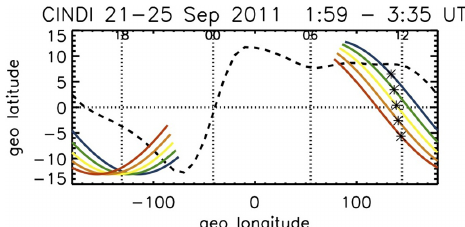
Figure 1. A diagram in geographic longitude and latitude of the ground track swaths from approximately the same universal time on the five quiet days preceding the storm event day (blue is 21 Septem- ber from 01:59UT to 02:54UT and red is 25 September from 02:40 to 03:35UT). Each swath covers the part of the orbit from 08:00 to 22:00 local time from that particular orbit and the asterisks de- note the position of the perigee. The vertical dotted lines denote the location of the local times on 21